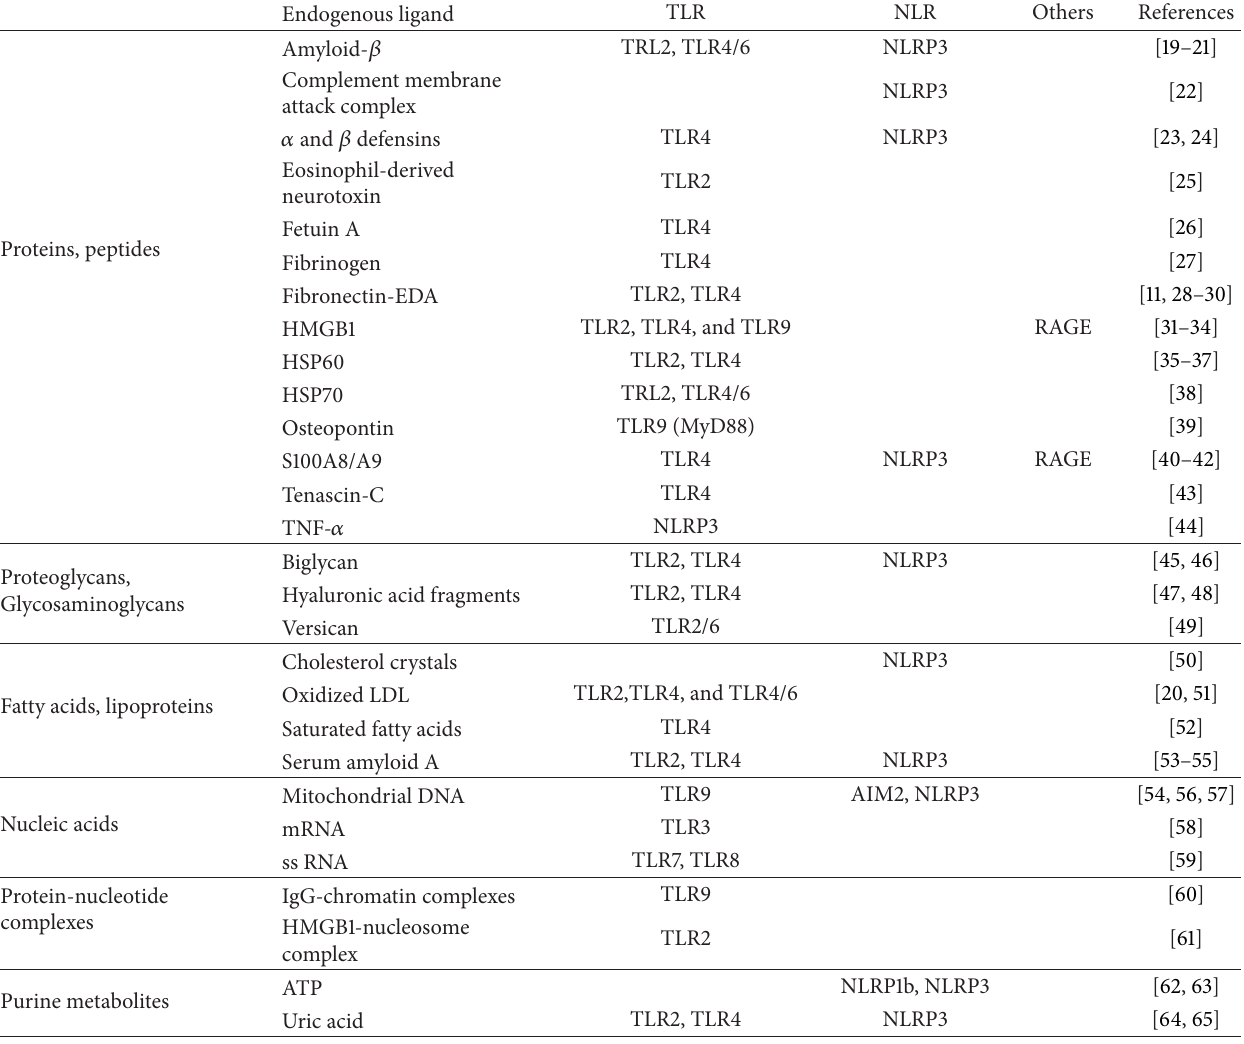
Table 1: DAMPs and their